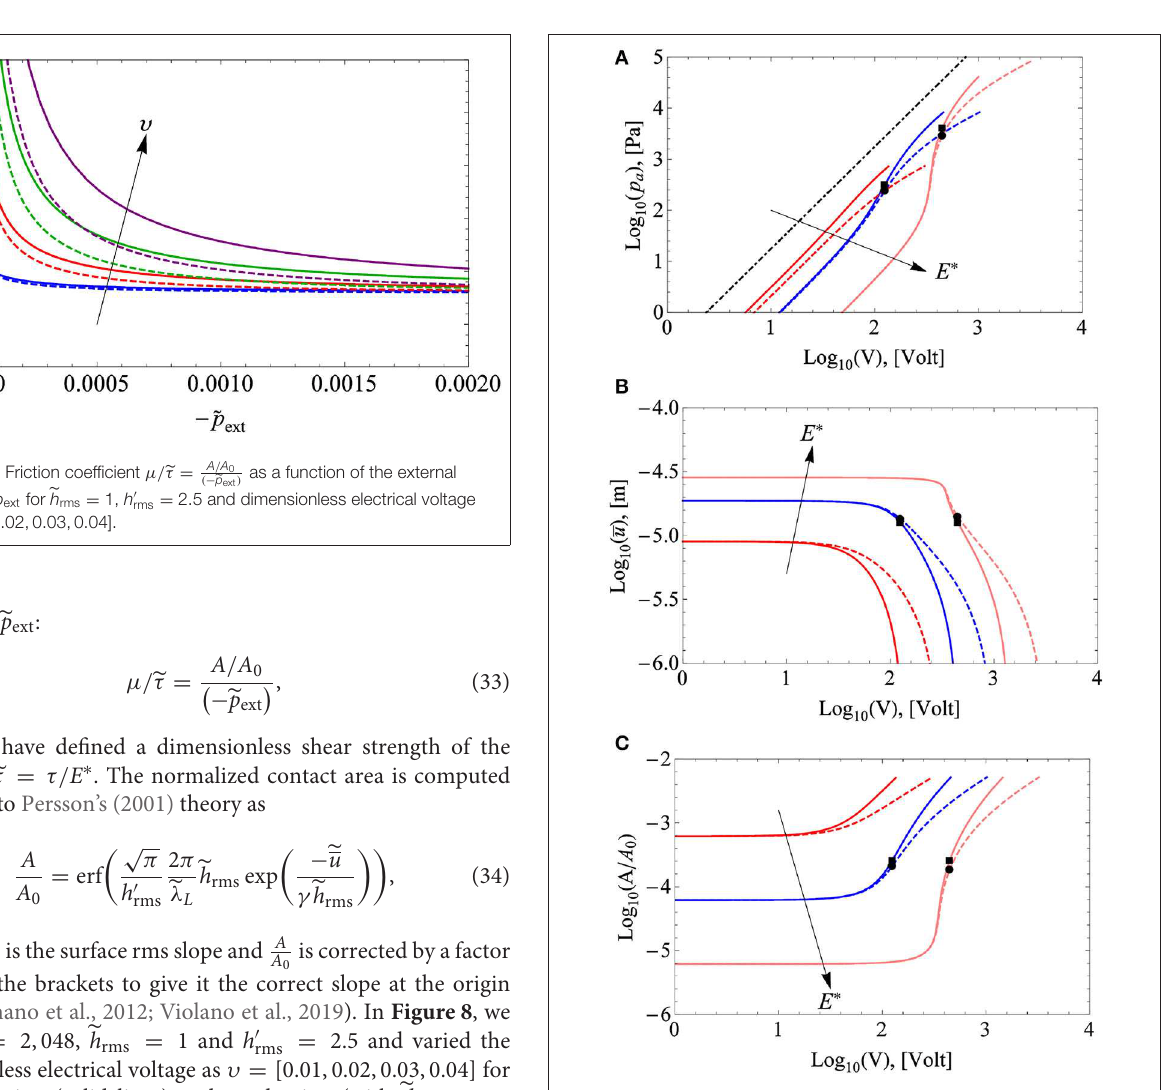
p ext p , (B) mean separation u , and = −